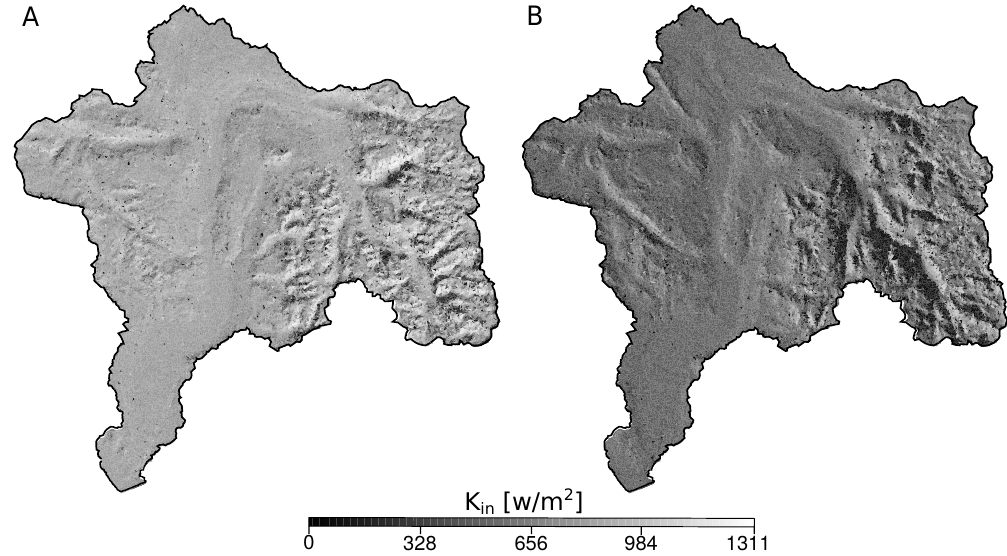
Figure 7. Instantaneous incident solar radiation flux ( K in ) for the Upper Green River Basin during the spring equinox (20 March) in year 2016 at ( A ) 12 PM and ( B ) 5 PM LST, (GMT-7). Radiation flux maps account for direct, self and remote shading, diffuse, atmospheric backscattered, and albedo-reflected